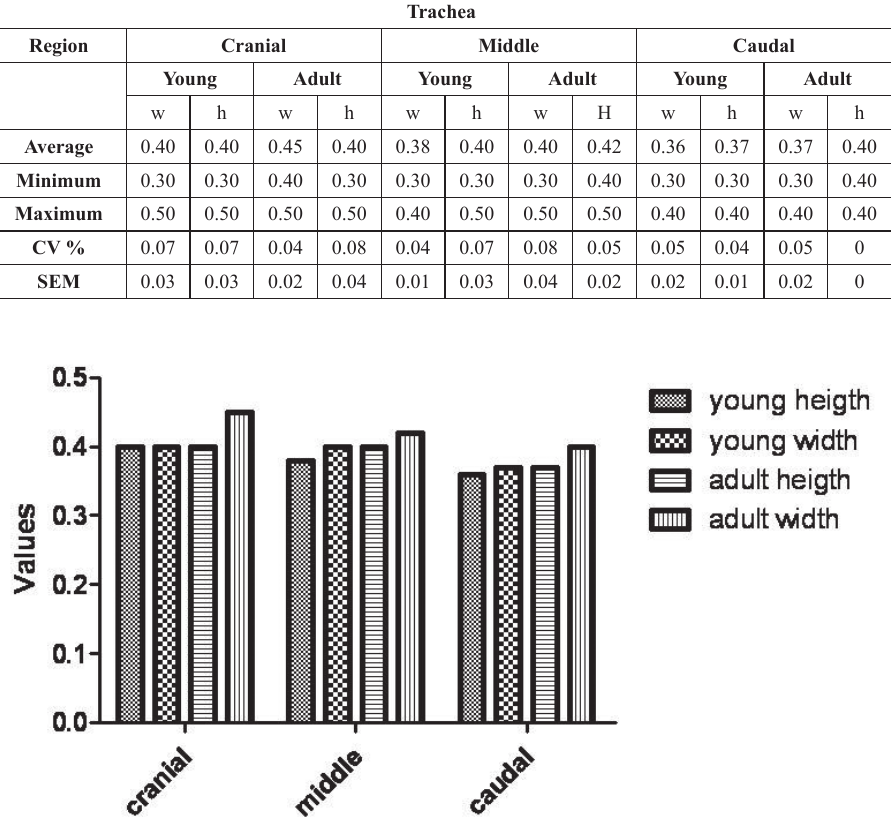
Fig. 2 - Mean values for height and width (cm) corresponding to the diameter of the trachea in three parts of young and adult animals, the cranial, middle and